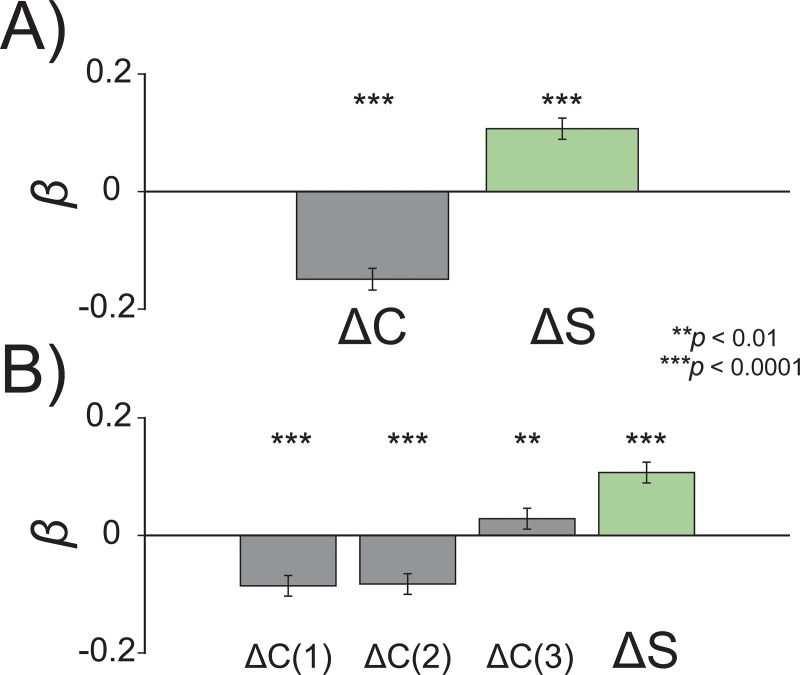
Results of the working memory task with two (A) and four (B) items in Experiment 8: whereas competitive items in memory (ΔC) have a repulsive effect on perceptual reports, the attractive impact of previous stimuli (ΔS) and of the related perceptual decisions was unaffected by the memory manipulation. The raw data are available at https://doi.org/10.5281/zenodo.2544946. ΔC, competitor(s) relative size; ΔS, delta stimulus.